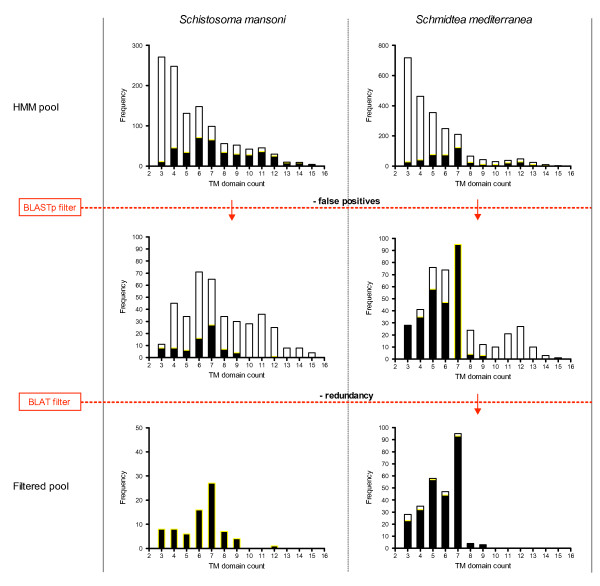
HMM-based identification of S. mansoni and S. mediterranea GPCRs. The transmembrane frequency distribution of the S. mansoni (left) and S. mediterranea (right) predicted proteomes is shown as predicted by HMMTOP at various junctures of the bioinformatics protocol for the Rhodopsin family. The top graphs overlay the HMM-derived sequence pools (black, yellow outline) on top of the entire predicted proteomes (white, black outline) in the assayed TM domain range (3-15). The middle graphs overlay the BLASTp filtered sequence pools (black, yellow outline) on top of the HMM-derived pools (white, black outline). The bottom graphs display the final distributions upon filtering, and after the removal of redundant sequences in the case of S. mediterranea.